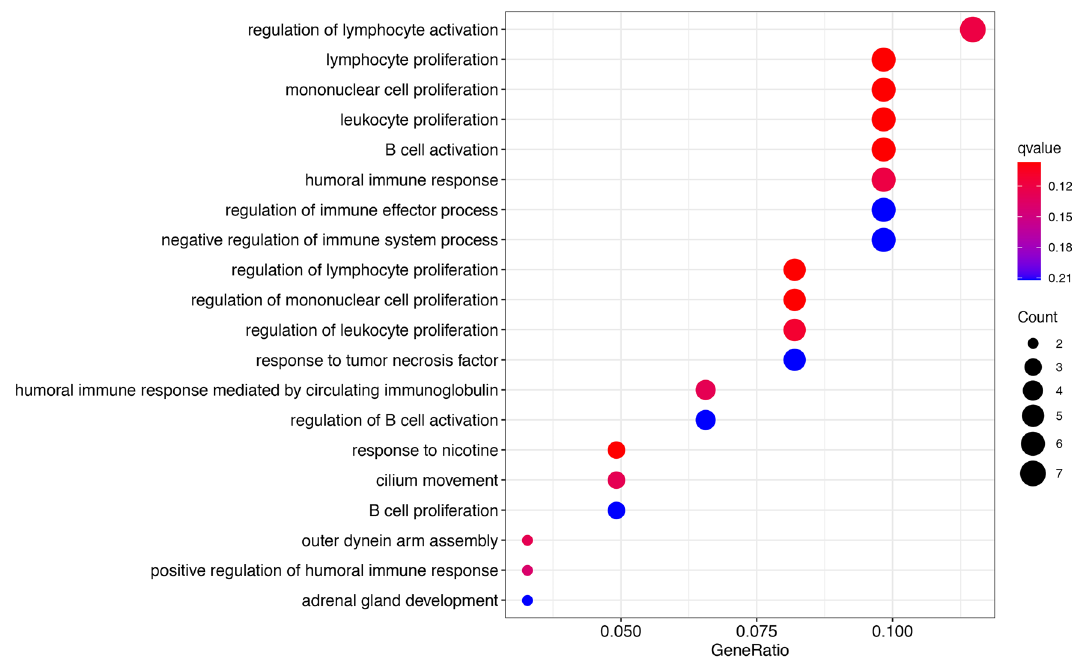
Figure 3. GO enrichment analysis of the DEGs between high- and low-TMB groups.